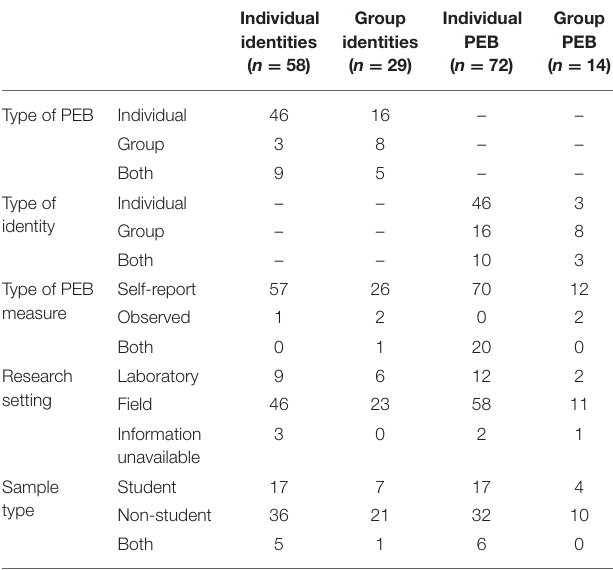
TABLE 2 | Summary of individual and group identities included for analysing type of behaviour, measure, research setting, and sample